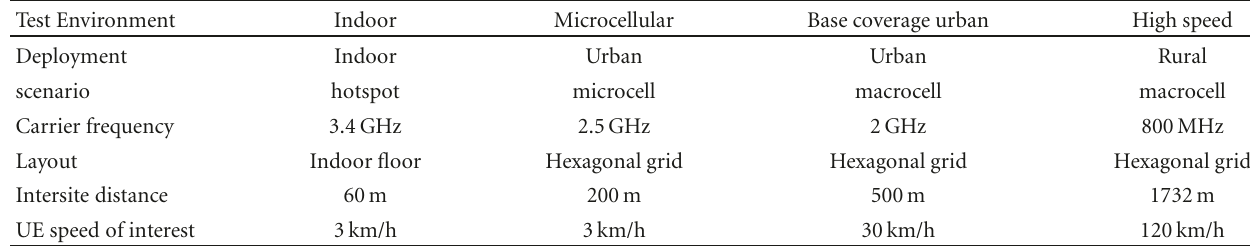
Table 4: ITU IMT-Advanced deployment scenarios.